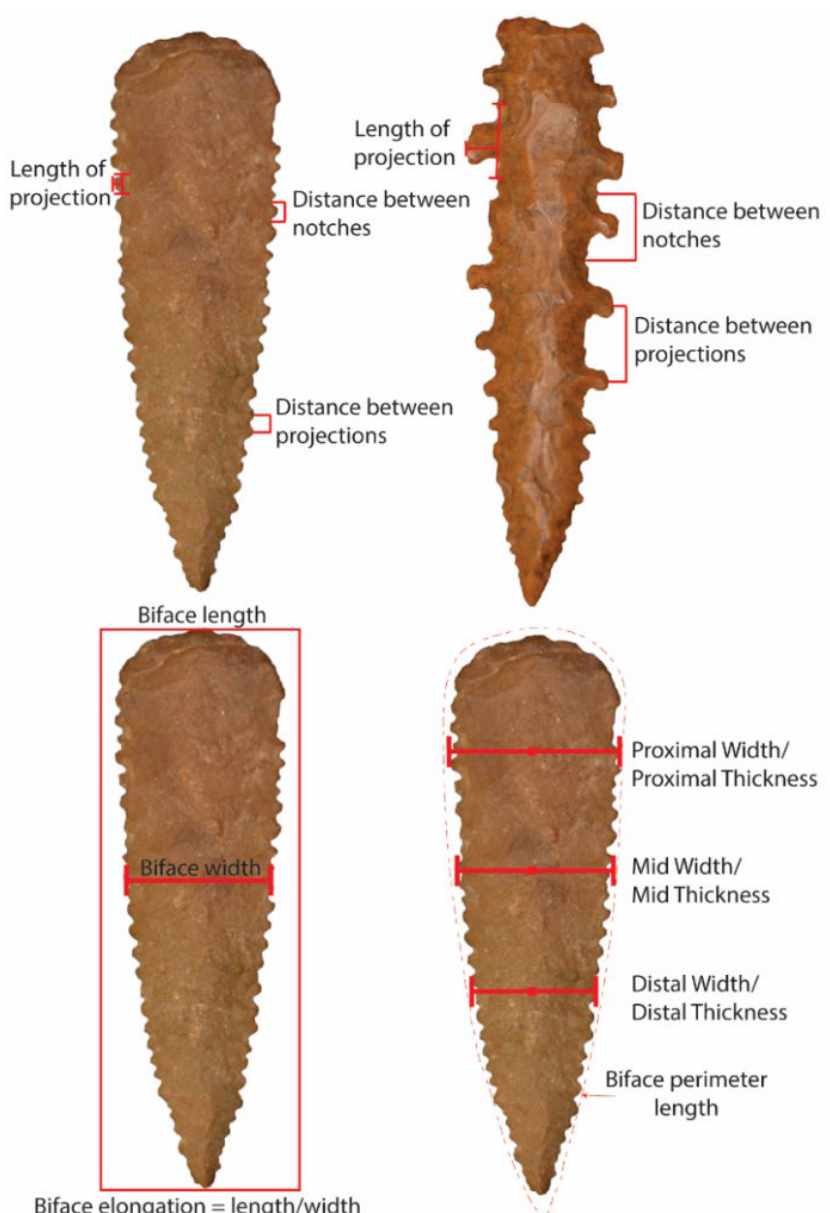
Figure 6. Quantitative measures of marginal projections and biface